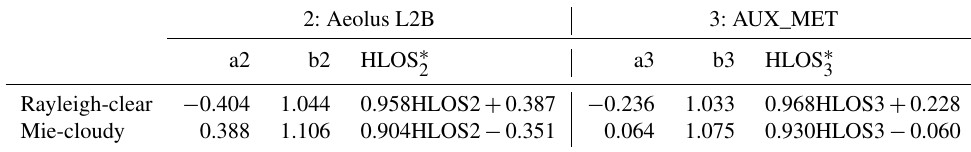
Figure 6. Wind differences (Aeolus-WPR) with range bins for the (a) tropics and (b) extratropics. Left: distributions of bias and scaled MAD of wind differences over different range bins, with shading areas representing the uncertainty. Right: the number of available match-ups at each range bin. Blue and orange colours indicate the results for the Rayleigh and Mie channels, respectively. Note: the heights on the y axis are just for reference, which are not exactly same with the actual heights of each vertical range bin. Table 5. Calibration coefficients of Aeolus L2B and NWP